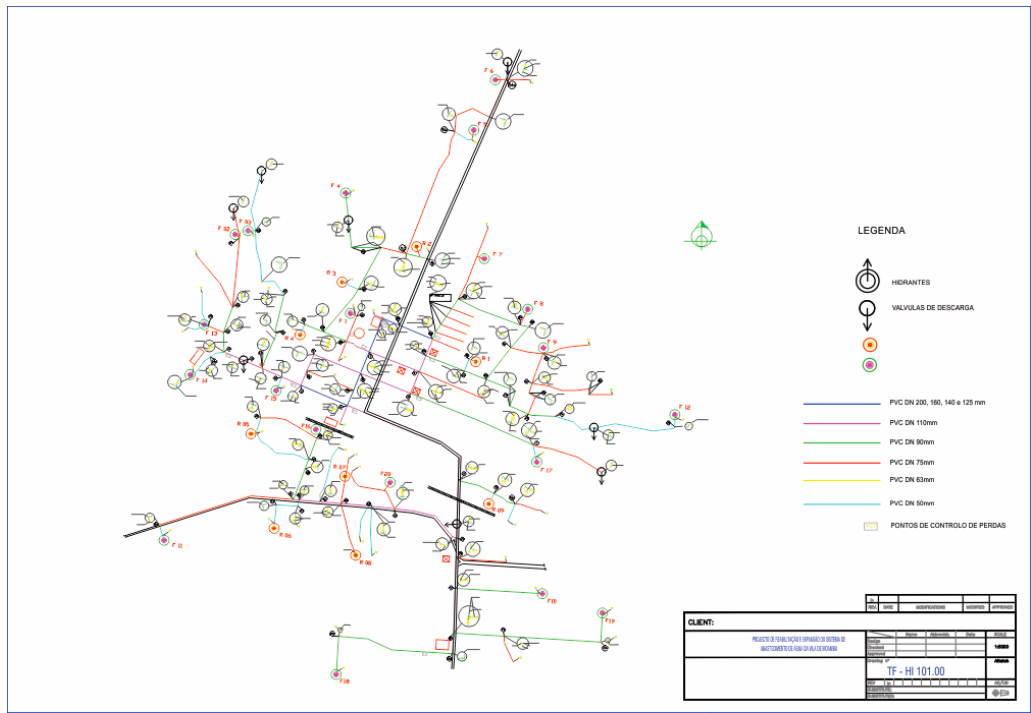
Figure A1. Design map of Moamba’s water distribution network 2012. Source: Collins Sistemas de Agua Lda.